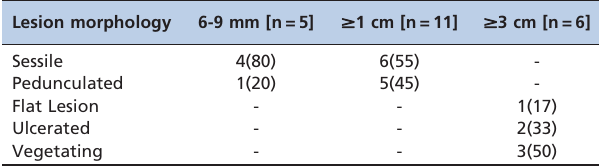
dimensions of lesions $ 6 mm identified in computed tomography colonography and complete